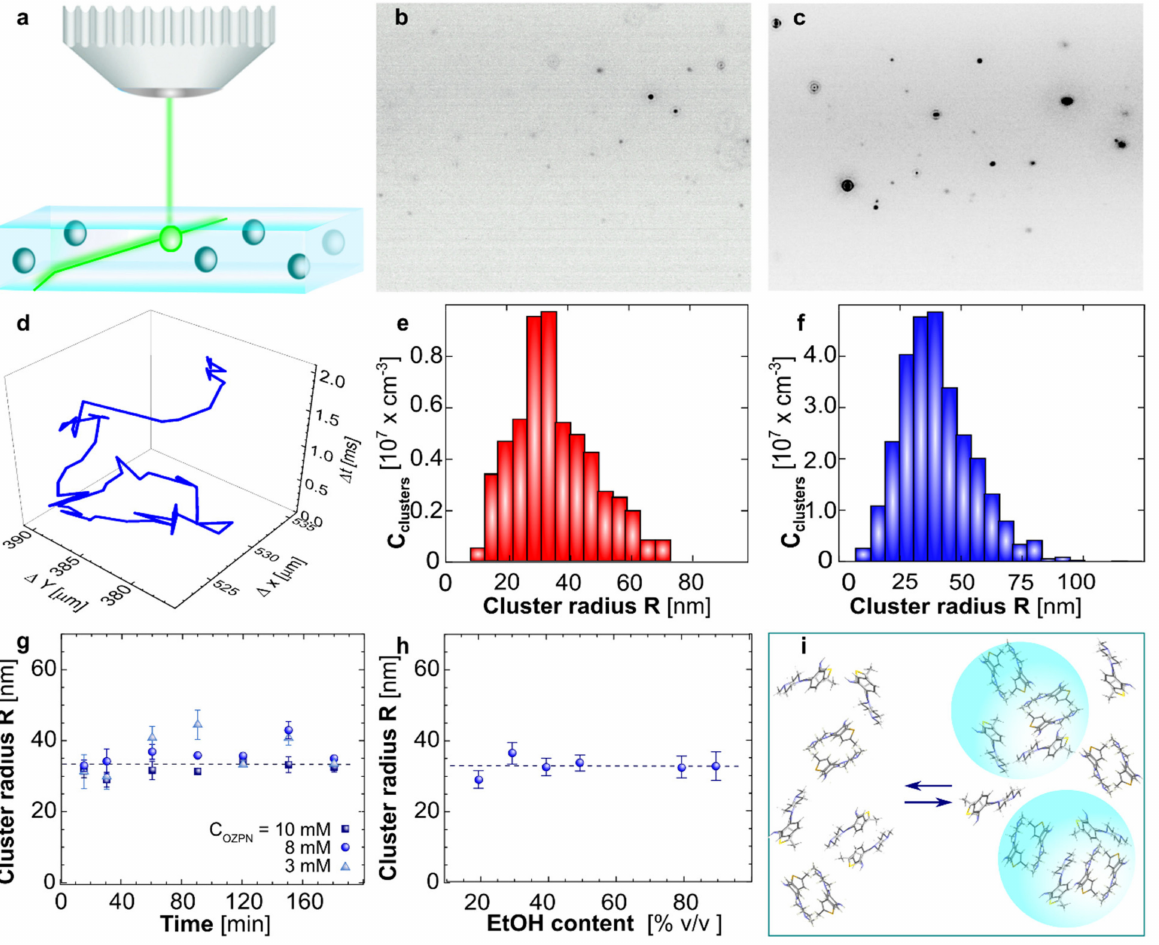
Figure 3. The mesoscopic OZPN rich clusters. ( a ) Schematic of oblique illumination microscopy (OIM). ( b , c ) Typical images, shown as negatives, in which the clusters appear as dark speckles, of OZPN-rich clusters in undersaturated OZPN solutions in H 2 O, in ( b ) and in 80/20 ( v / v ) EtOH/H 2 O, in ( c ) The observed volumes are 120 × 80 × 5 µ m 3 (L × W × H). ( d ) The trajectory of a cluster in the plane of the image. ( e , f ) Distributions of cluster sizes obtained from five OIM movies recorded at distinct solution locations in undersaturated OZPN solutions in H 2 O, in ( e ) and in 80/20 ( v / v ) EtOH/H 2 O, in ( f , g ) The time evolutions of the average cluster radius R in OZPN solutions with three concentrations in 80/20 ( v / v ) EtOH/H 2 O solutions. ( h ) The average cluster radius R in EtOH/H 2 O solvents of different composition. ( i ) Schematic of formation of mesoscopic OZPN-rich clusters (highlighted in blue spheres) owing to the accumulation of transient